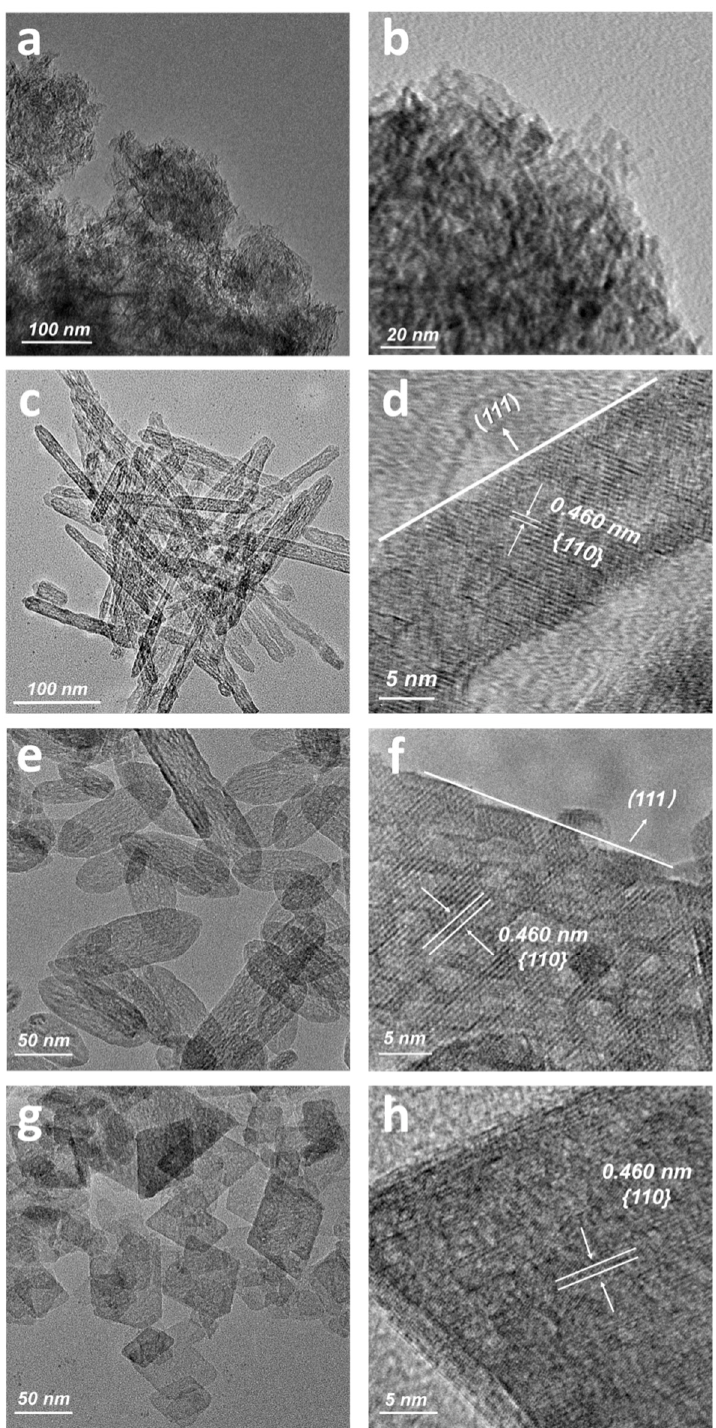
Figure 1. TEM images of the γ -alumina samples ( a , b ) CA; ( c , d ) AN; ( e , f ) AH; ( g , h )